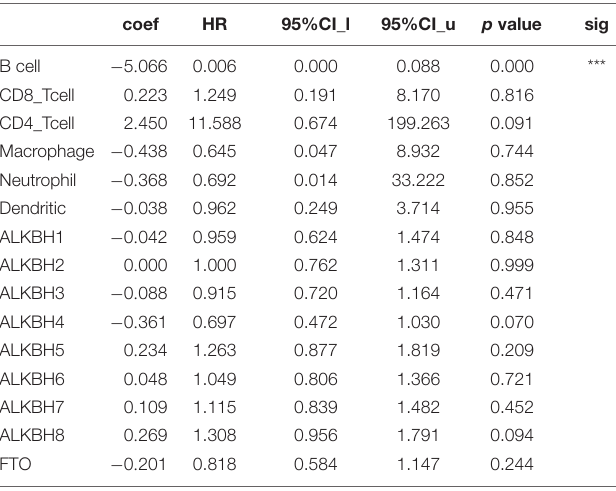
TABLE 2 | The Cox proportional hazard model of the ALKB family and six tumor-infiltrating immune cells in LUAD.